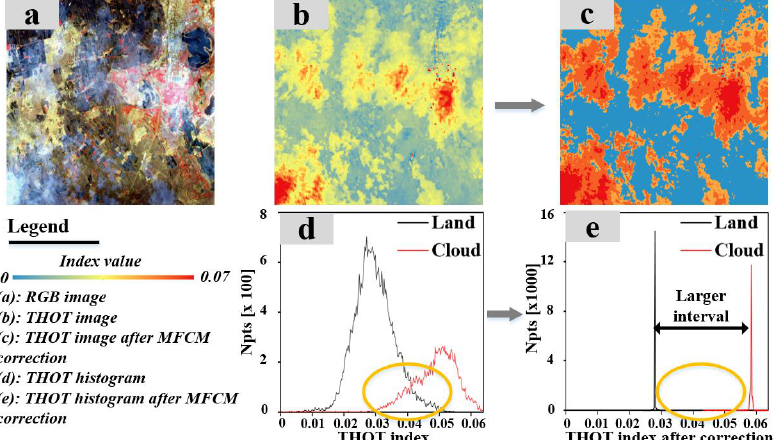
Figure 3. Graph showing the principle of the function used in the modified fuzzy C-means (MFCM) using the case of a Landsat-8 image (p120r028) of site a. ( a ) is the RGB image, ( b ) is the temporal haze optimized transformation (THOT) image, and ( d) is the histogram of the THOT image; ( c ) is the THOT image after MFCM correction, and ( e ) is its corresponding histogram.